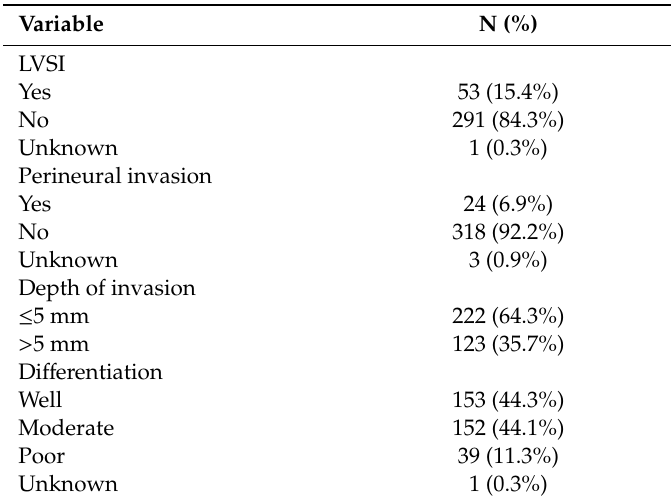
FIGO, International Federation of Gynecology and Oncology; IGFLND, inguino-femoral lymph node dissection; uVIN, usual-type vulvar intraepithelial neoplasia; dVIN, di ff erentiated vulvar intraepithelial neoplasia; LVSI, lymphovascular space invasion. a Di ff erent groin procedure in alternate groins are included in each group (% not calculated). b Four patients had chemoradiation, c four patients excluded due to follow-up < 6